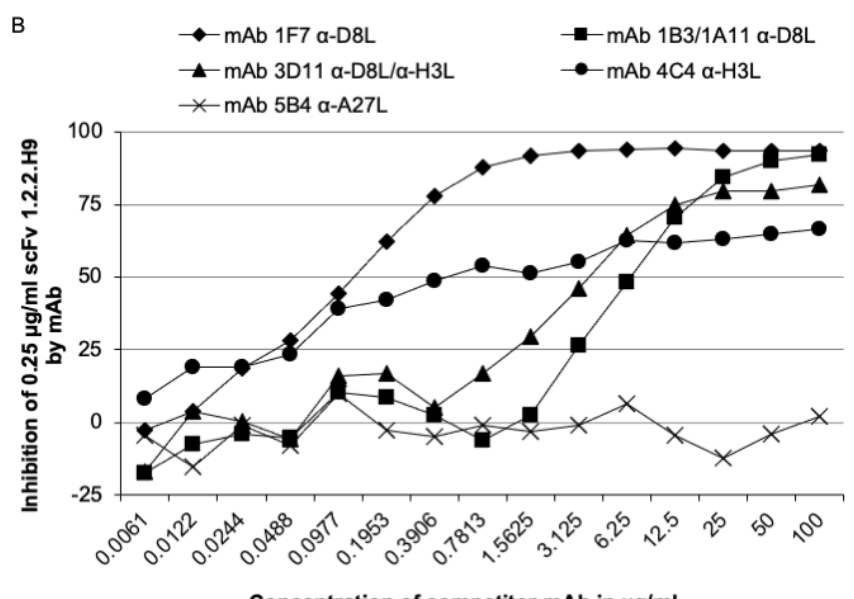
Figure 7. Inhibition of mAb in binding to their epitopes by scFv1.2.2.H9 with a starting concentration of 100 µg/mL scFv-1.2.2.H9 ( A ) and vice versa mAbs 1F7, 1B3/1A11, 3D11, 4C4, 5B4 ( B ). Microtiter plates were coated with 2 µg/mL VACV Elstree and the first scFv/mAbs were titrated. The results demonstrate the average from three independent assays. A reduction in the photometer adsorption (OD 450 nm ) of ≥ 50% indicated that two tested mAbs bind to identical or closely related antigenic sites. ( A ) Inhibition ( ≥ 50%) of mAb 1F7 was achieved with about 6.25 µg/mL scFv-1.2.2.H9. ( B ) The mAb 1F7 with at least 0.1953 µg/mL. More than 12.5 and 6.25 µg/mL of mAbs 1B3/1A11 and 3D11 is required to block the scFv-1.2.2.H9, respectively. A total of 0.7813 µg/mL of mAb 4C4 blocks the binding of scFv-1.2.2.H9.